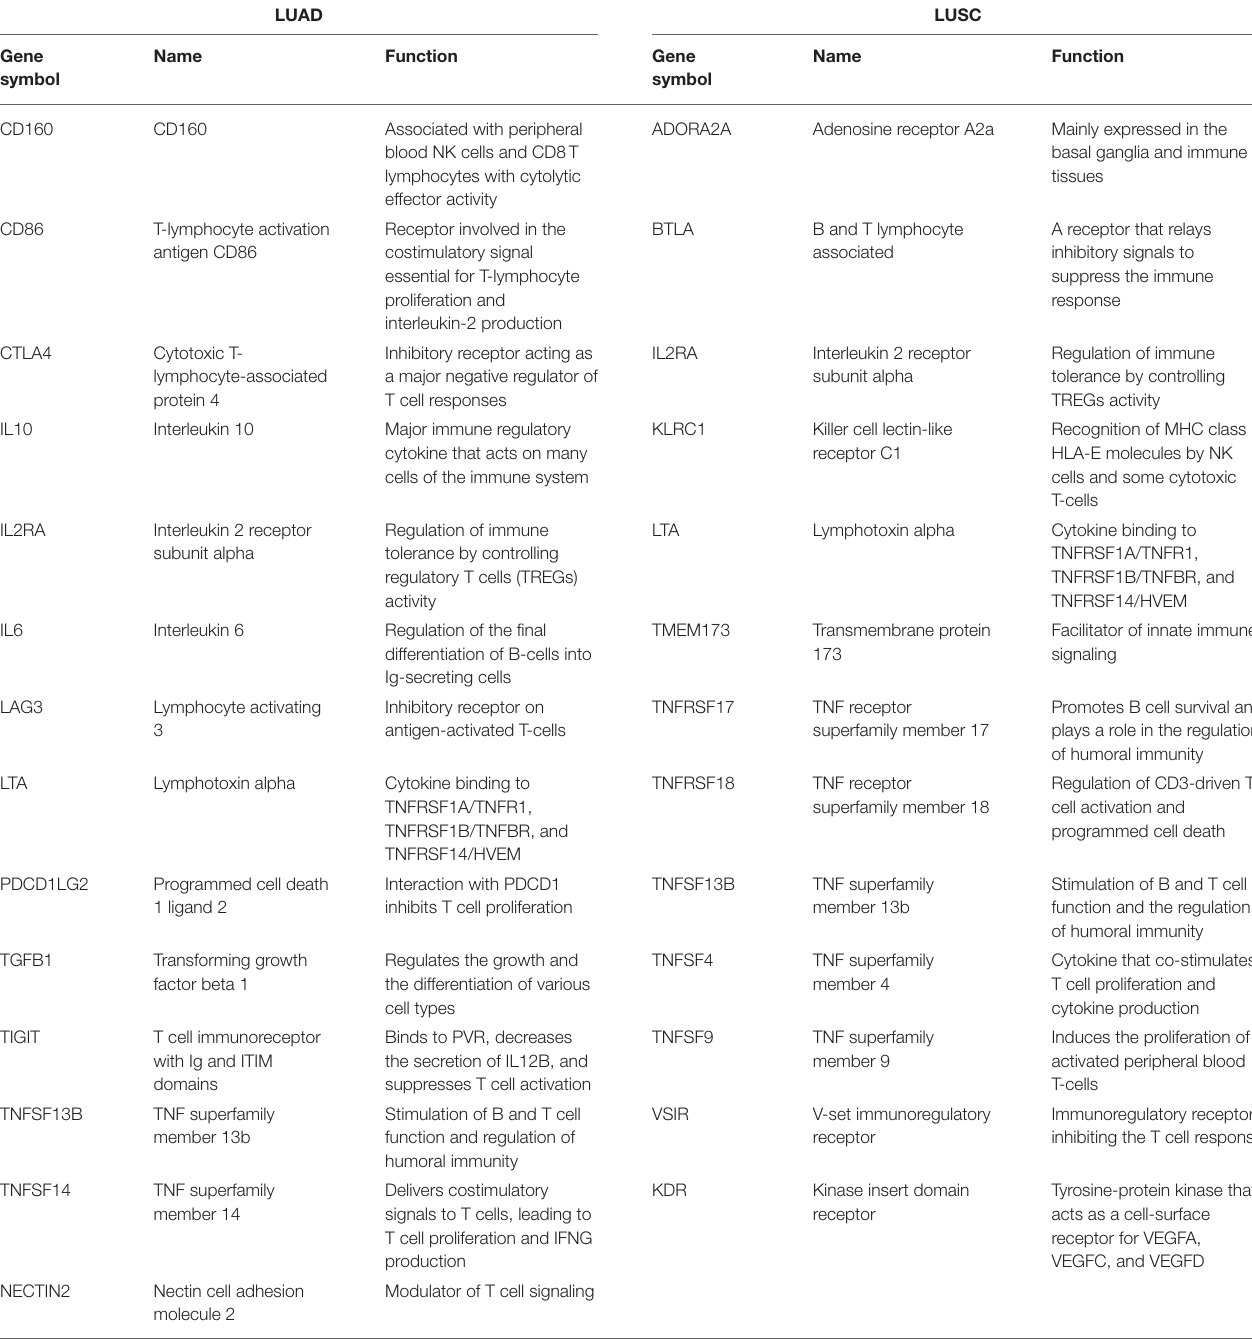
TABLE 1 | Functions of the genes included in the prognostic